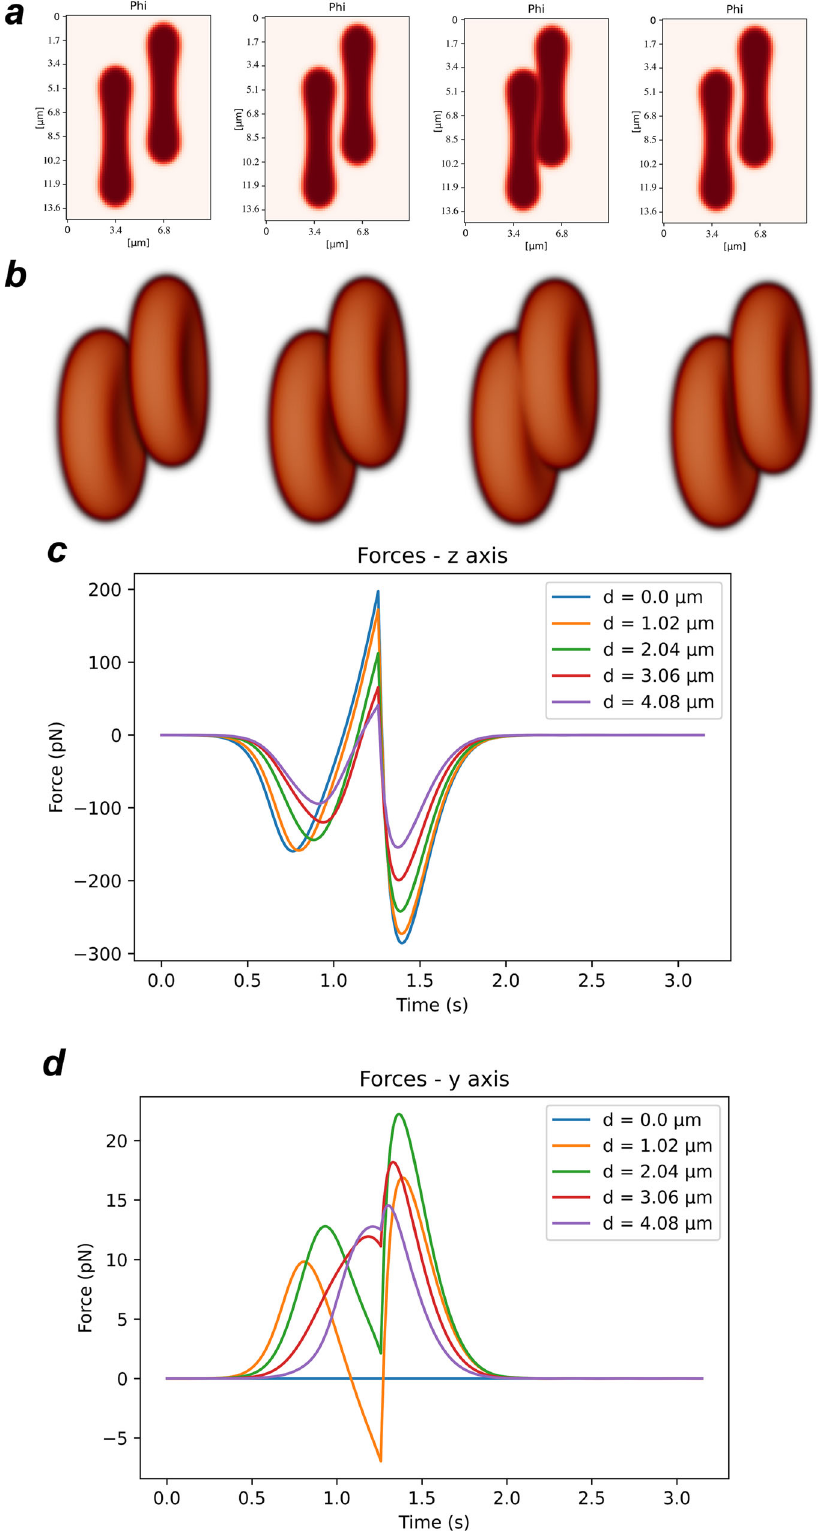
Fig. 5 Simulation time-lapse of two erythrocytes being pushed against each other off centred and then pulled apart. a Mid-slice pro fi le and b corresponding 3D representation with offset distance d = 3.06 μ m. The images correspond to the times t = 0, 0.62, 1.25, 1.88 s. Total force applied on the right erythrocyte by the left erythrocyte as a function of time ( c ) in the z direction and d in the y direction.